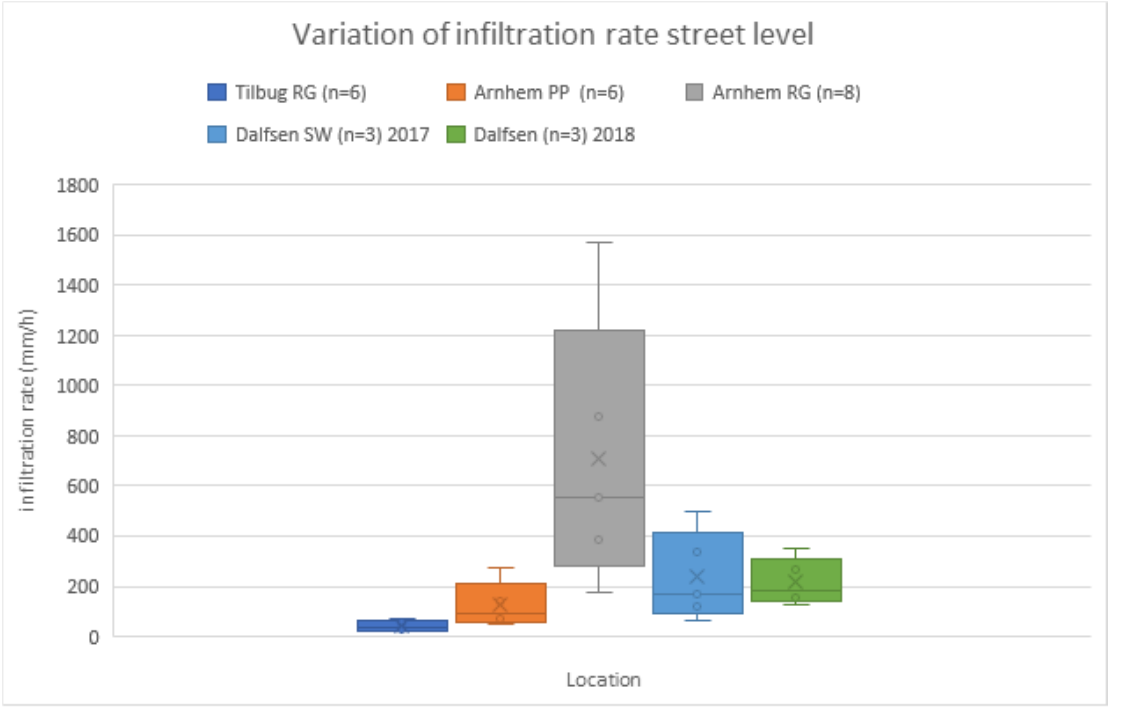
Figure 14. Range of infiltration rates in streets with multiple green infrastructure [19,49,50]. SW = Swale, RG = Raingarden, PP = Permeable Pavement, n = number of green